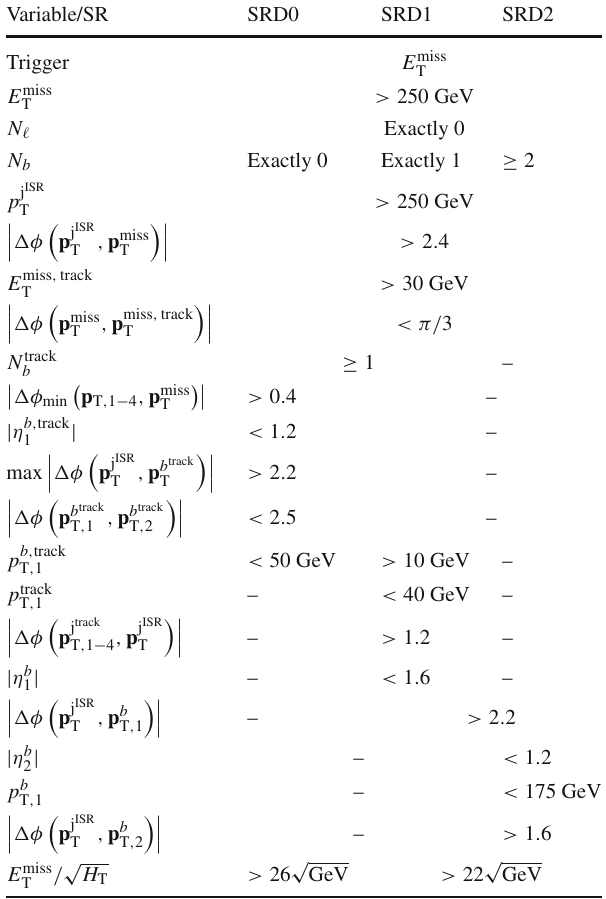
Table 4 Signal region selections for SRD. Variables involving track- jets are denoted with the label ‘track’. A dash indicates that no selection is applied